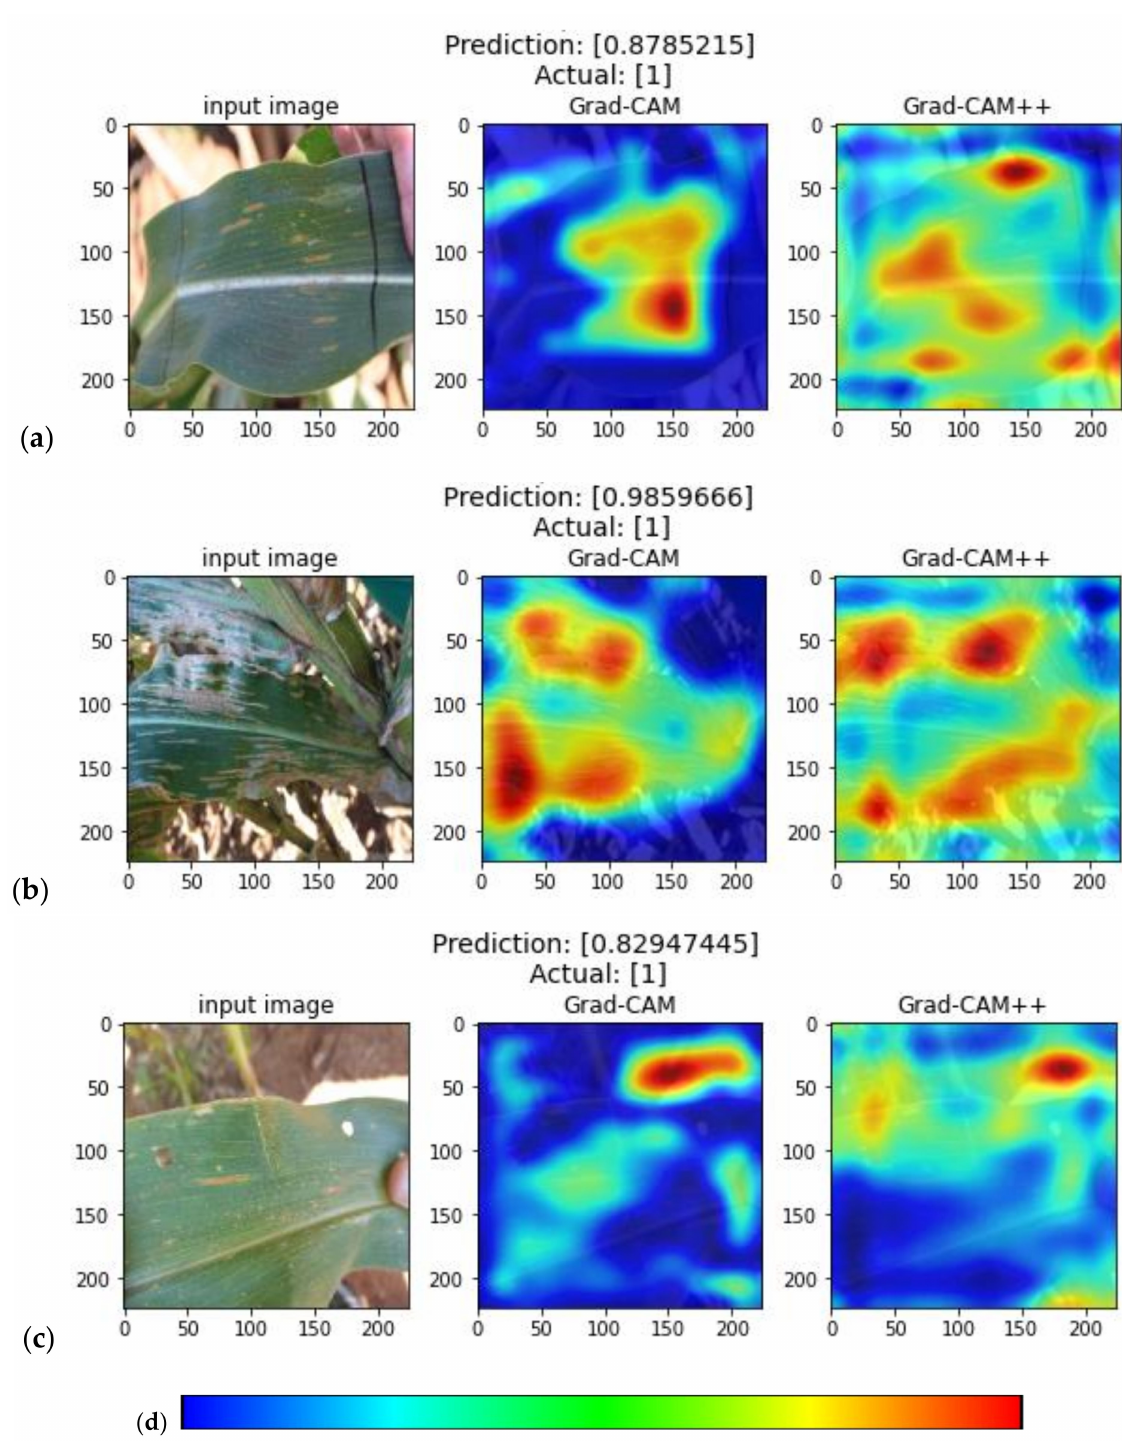
Figure 5. Heatmaps from Grad-CAM and Grad-CAM++ software, which are designed to illustrate image regions detected as GLS positive by a CNN, such as GLS_net, are shown here. Panels ( a – c ) show three GLS positive representative images from the IF dataset. Each panel shows (from left to right) the input image that was scored as GLS positive by GLS_net, the Grad-CAM heatmap, and the Grad-CAM++ heatmap, respectively. Panel ( d ) contains a colour scale to aid in interpretation, blue indicates no activation, while red indicates high levels of